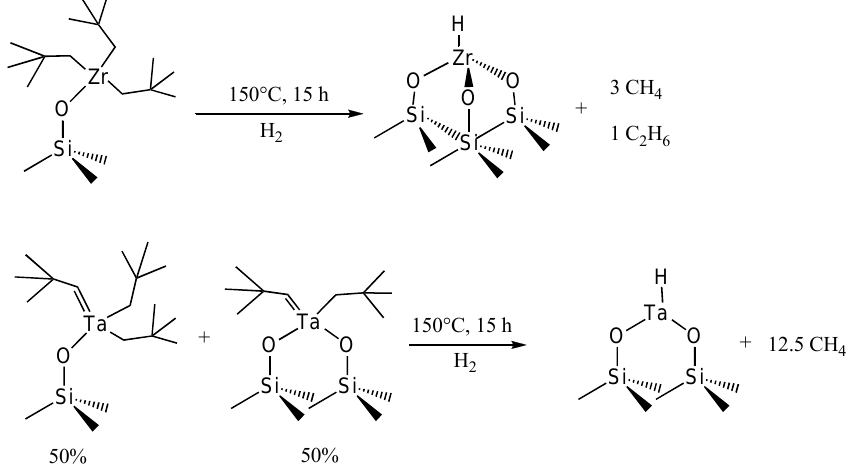
Figure 6. Grafted single-site Zr hydride and Ta hydride complexes as heterogeneous catalysts for the activation of light